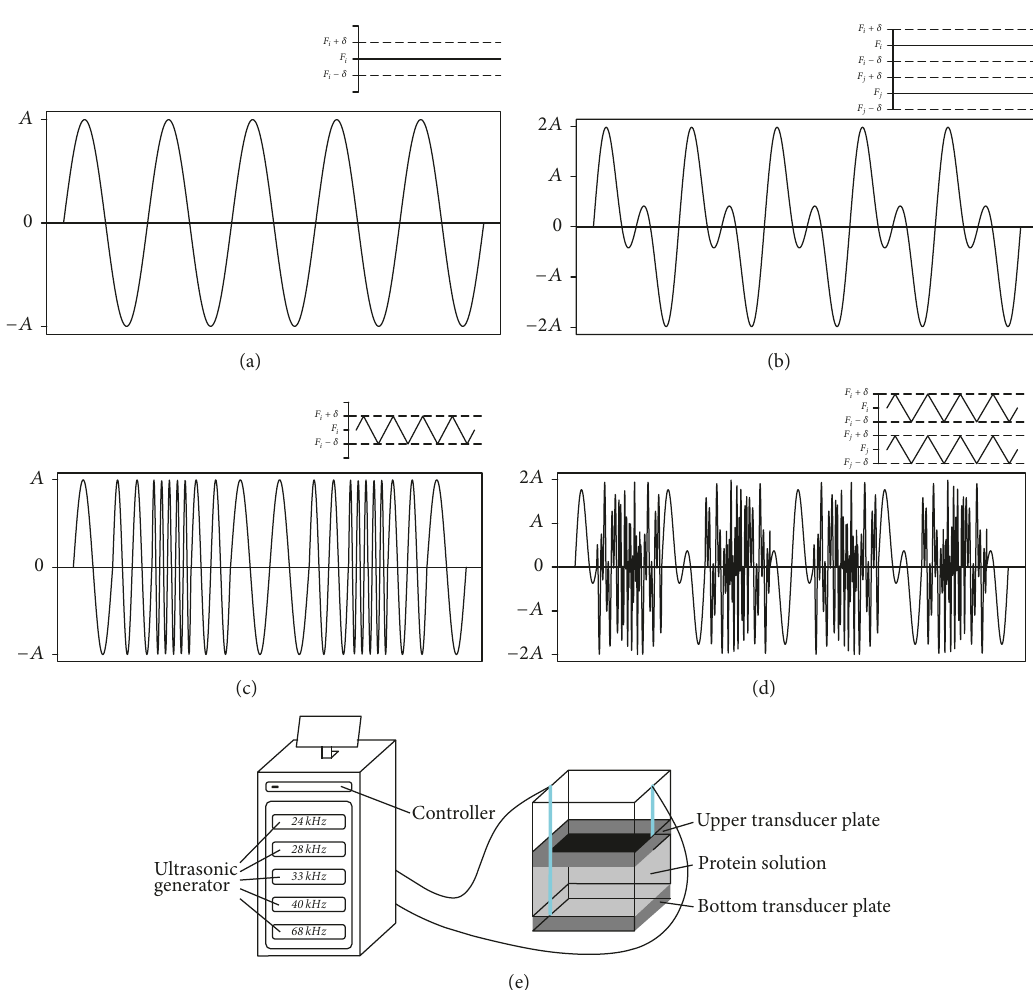
Figure 1: Ultrasonic patterns of single fixed frequency ultrasound (a), dual fixed frequency ultrasound (b), single sweeping frequency ultrasound (c), and dual sweeping frequency ultrasound (d). Equipment used for fixed and sweeping frequency ultrasound